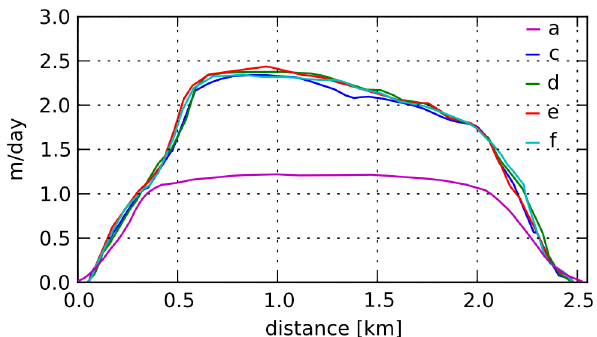
Fig. 8. Ice velocity at profile J1 on Jorum Glacier, derived from Figure 8. Ice velocity at profile J1 on Jorum Glacier, derived from ERS InSAR of Dec. 1995 ERS InSAR of December 1995 (a) ; from TerraSAR-X of October 2008 (c) , November 2008 (d) , April 2009 (e) , November 2009 (f) . (a); from TerraSAR-X of Oct. 2008 (c), Nov. 2008 (d), April 2009 (e), Nov. 2009 (f). small, the estimated thinning rates range between 1 m a − 1 and 4 m a − 1 near the glacier